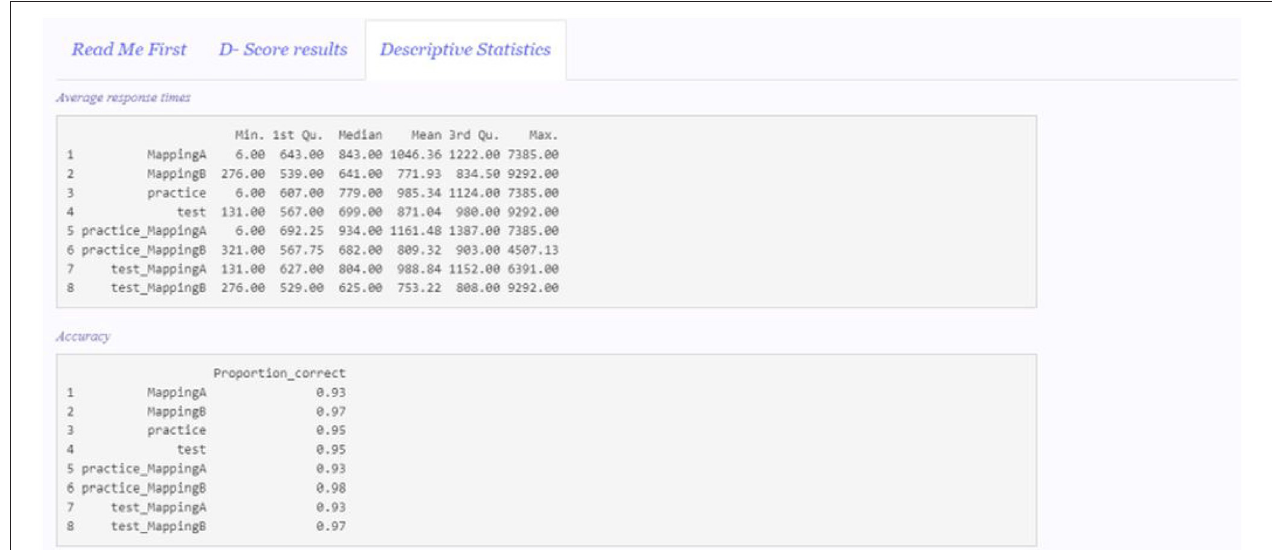
FIGURE 5 | Descriptive statistics